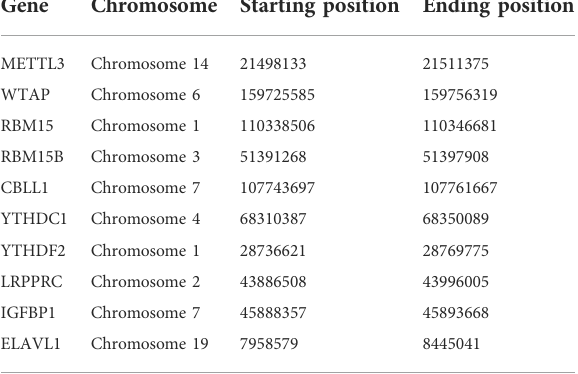
TABLE 2 Speci fi c characteristics of m6A regulators on